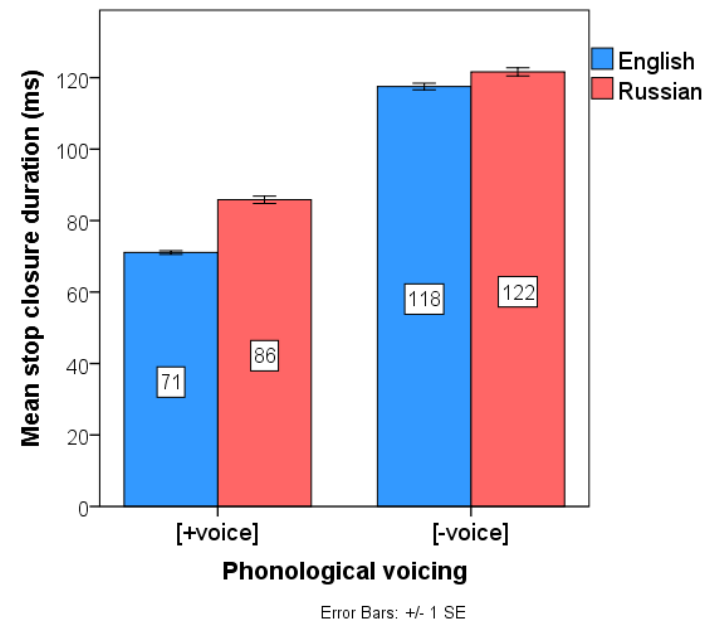
Figure 12. Mean voiced and voiceless final stop closure duration in learners’ English and Russian.